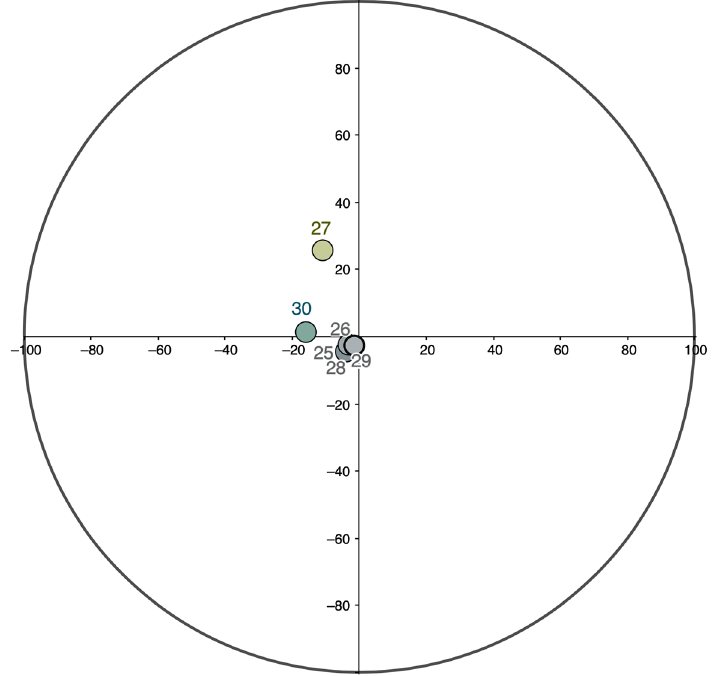
Figure 8. Hue (h°) and chroma (C) of the environmental background colors from the charts of Sec- Figure 8. Hue (h ◦ ) and chroma (C) of the environmental background colors from the charts of Section tion IV of the Reference Book ; projection into the CIELCh color circle. IV of the Reference Book ; projection into the CIELCh color